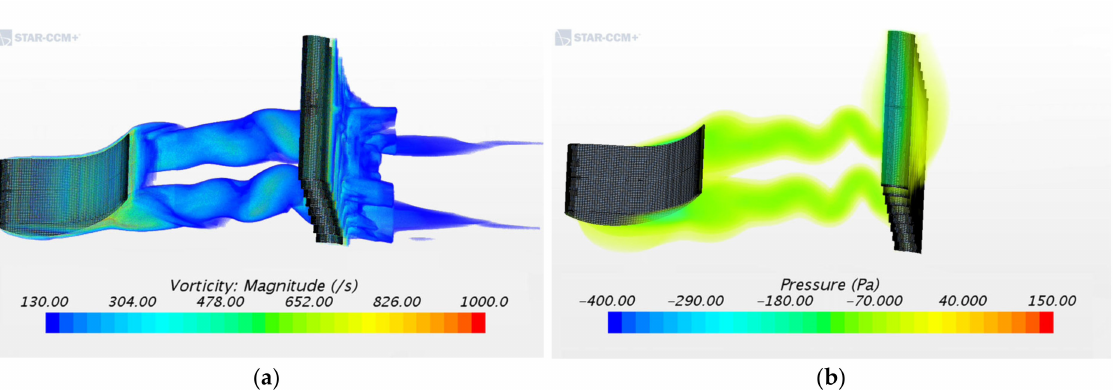
Figure 8. Impact of shutter-like fairing structure on 3D flow field. ( a ) High vorticity of wingtip vortex is reduced significantly by passing through the shutters; ( b ) low-pressure condition in the vortex is improved because of the reduction in